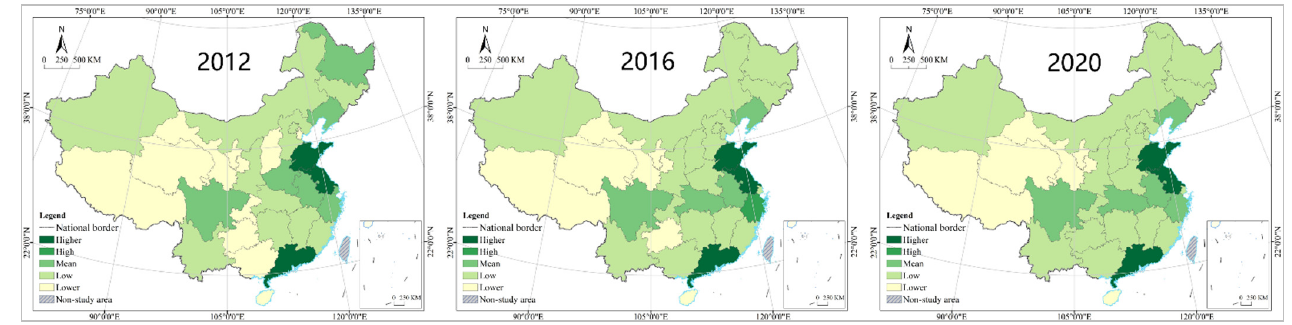
Figure 9. Analysis of spatial clustering of urban service-land.